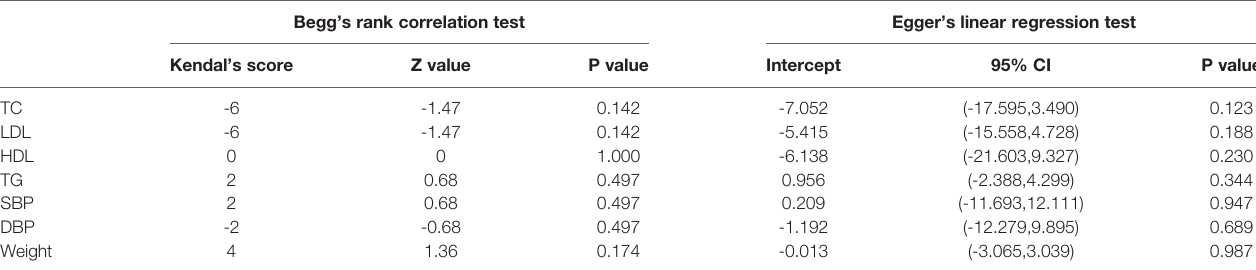
TABLE 5 | Assessment of publication bias. Begg ’ s rank correlation test Egger ’ s linear regression